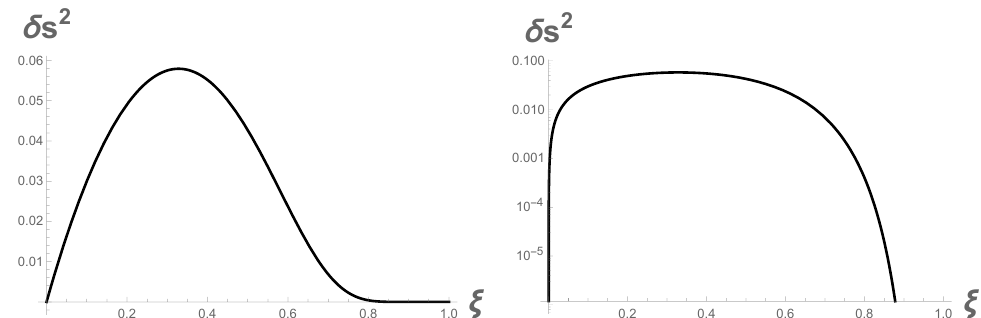
Figure 4. ( Left ) The discontinuity, Equation (12), at late times over the shock wave for ultra-relativistic speed ξ (cid:39) 0.9 is approximately zero. ( Right ) A log plot of Equation (12) to demonstrate the rapid fall off at high speeds. Here, (cid:101) ≡ 1 − ξ , and the final coast speed is greater than zero but less than the speed of light, 0 < ξ <